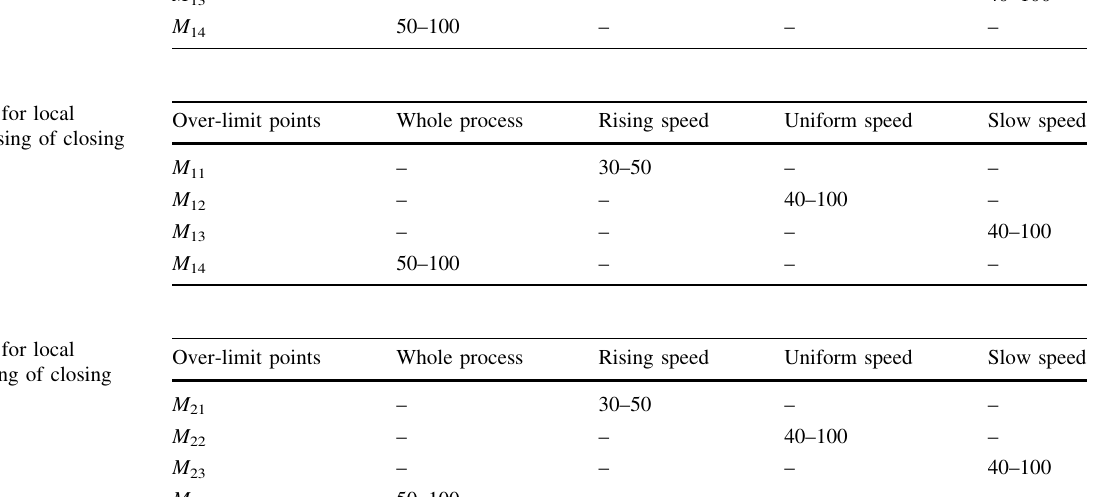
resistance reducing of opening door